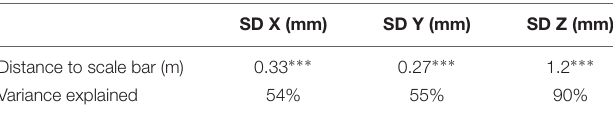
TABLE 6 | Mean and standard deviation of the relative measurement errors for objects contained in the scene (experiment 2). Mean (%) SD